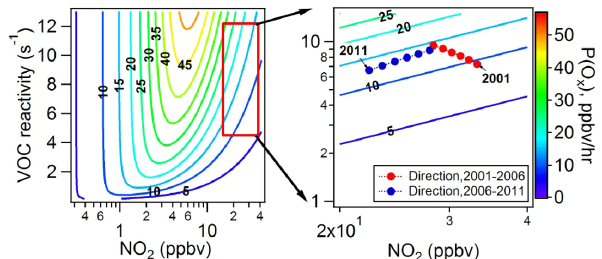
Figure 11. (Left) contour plot of instantaneous total oxidant pro- duction as a function of VOC reactivity and NO x concentrations. Contour lines represent changes in ozone production of 5ppbvh − 1 . The red box represents recent conditions in Beijing; (right) mod- eling the evolution of total oxidant production in summer between 2001 and 2011. The red line represents temporal direction between 2001 and 2006, and the blue line represents temporal direction be- tween 2006 and